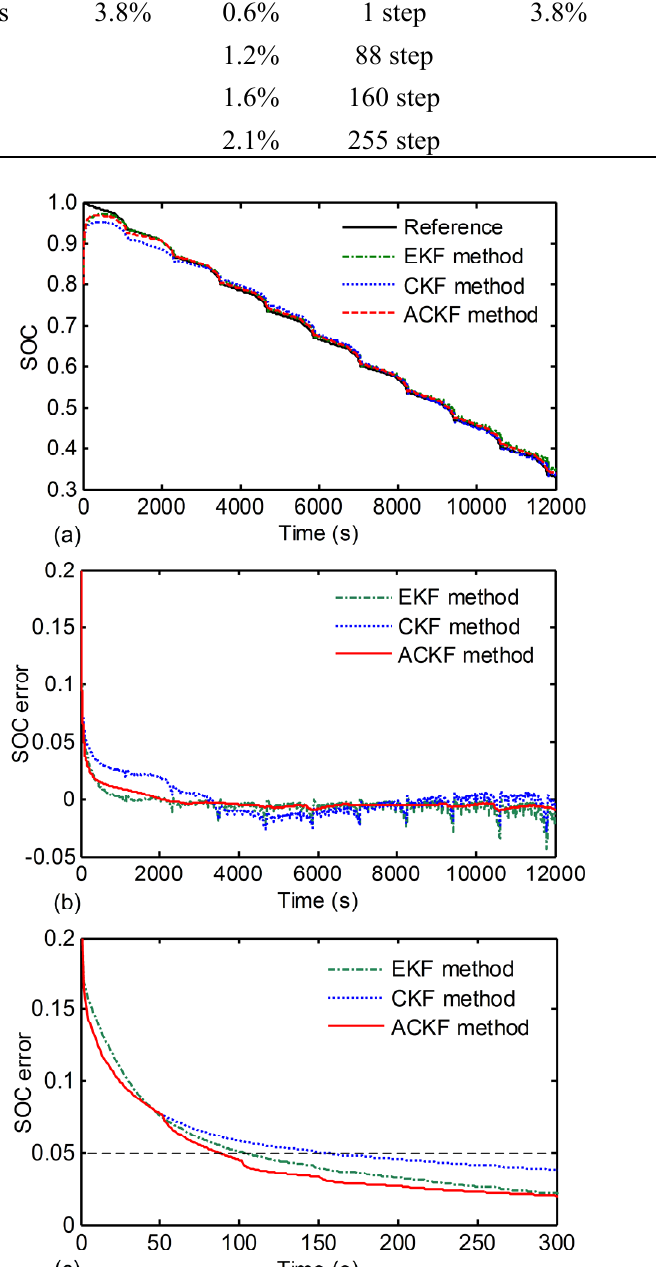
Figure 10. SOC estimation results under NEDC test: ( a ) SOC; ( b ) SOC error; ( c ) zoom figure for ( b